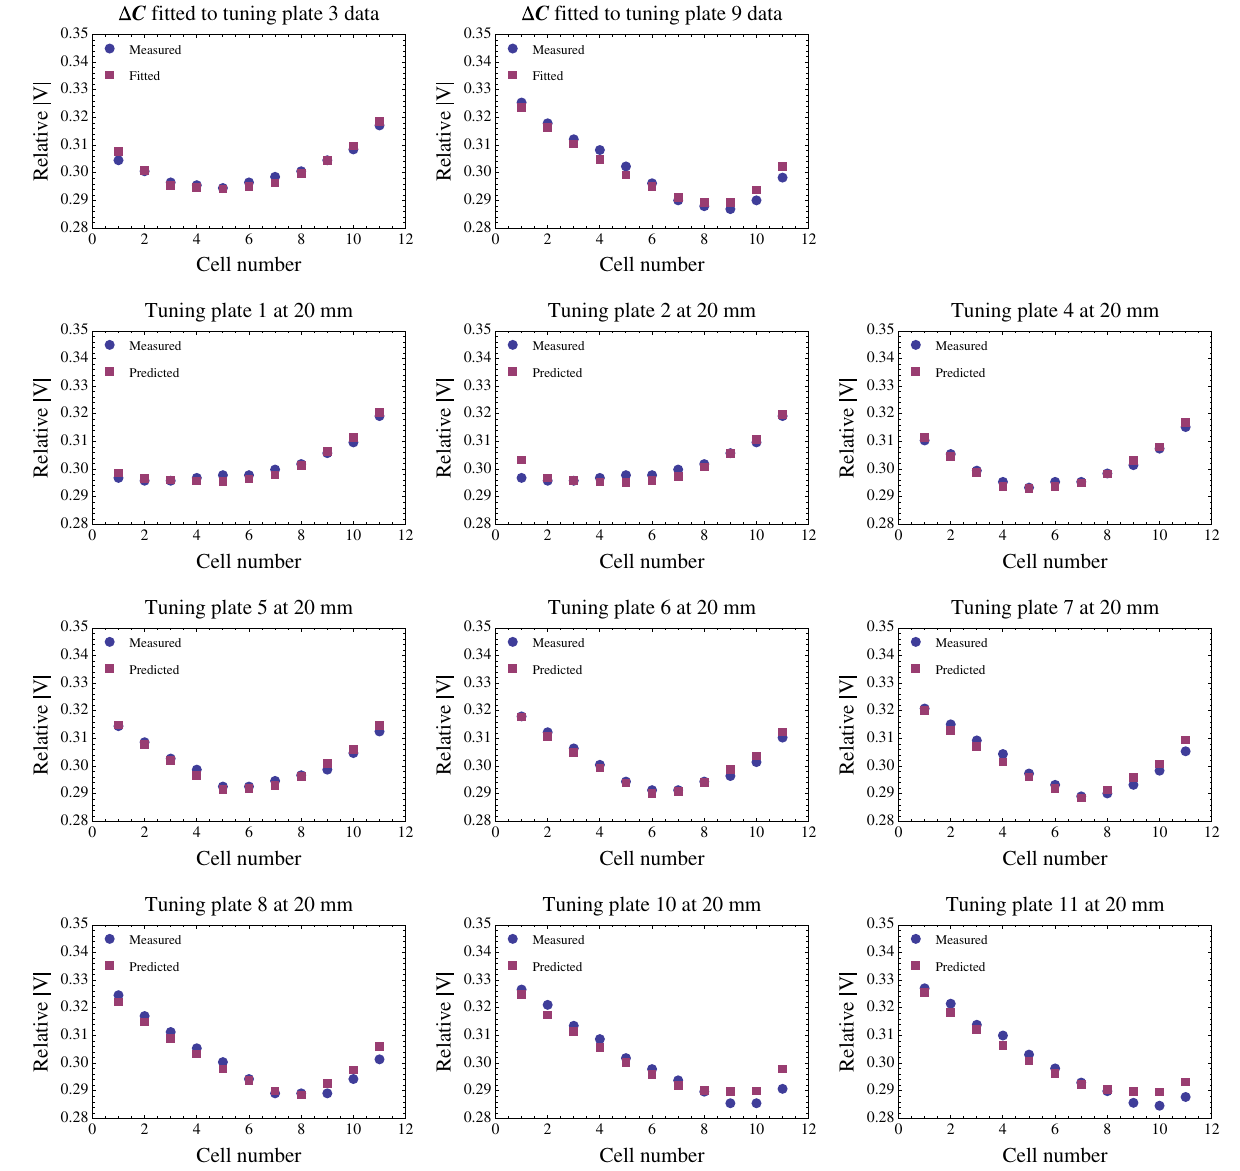
FIG. 14 (color online). We fit Δ C to the measured relative field profile for the cases when the tuning plates in cells 3 and 9 were set to 20 mm. We then used the Δ C that we found (see Fig. 13) and applied it to the model. The results are plotted here for the other cells when each plate was raised to 20 mm. We can see that the predicted relative voltage and the measured relative voltage match extremely